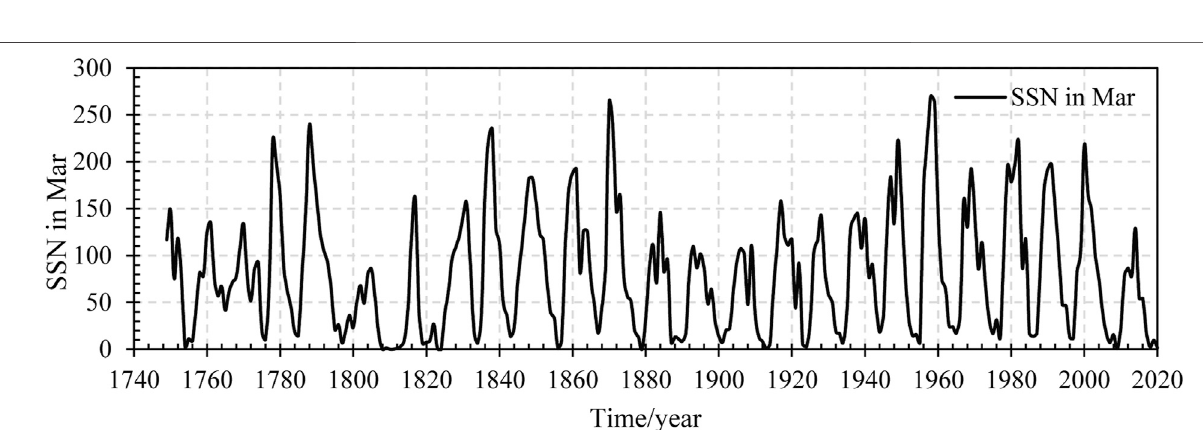
FIGURE 7 | Sunspot numbers (SSNs) in March during 1749 – 2020.